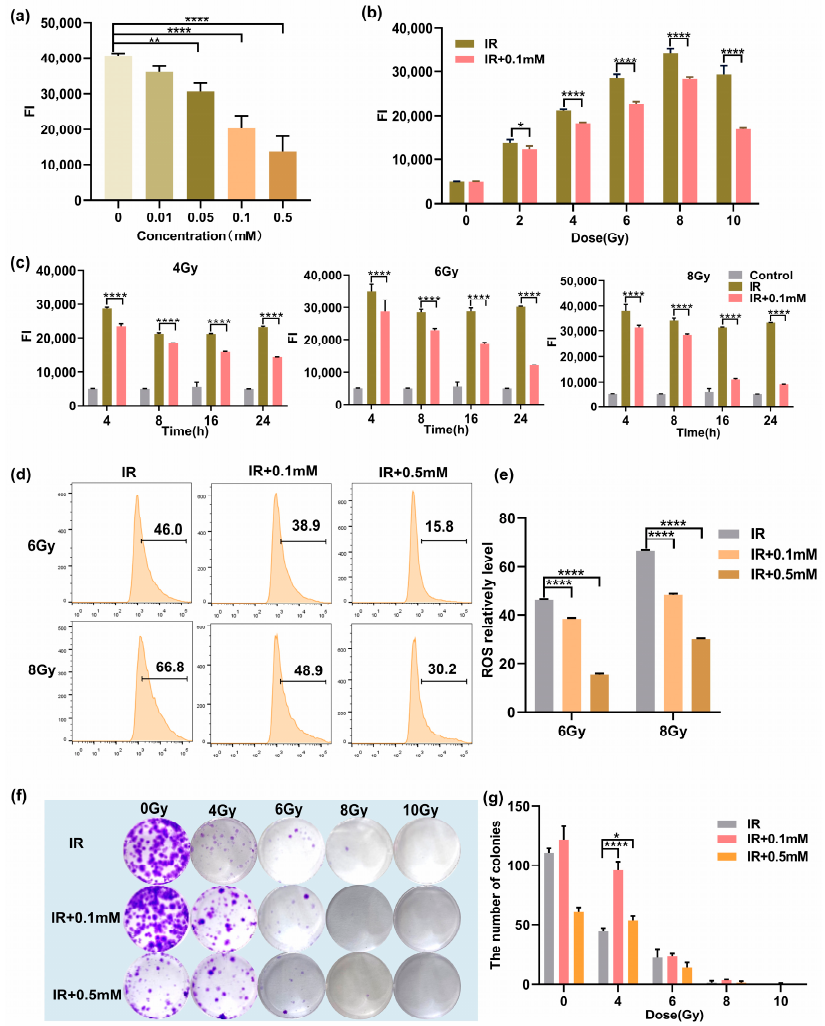
Figure 3. ( a ) The ROS levels in cells treated with various concentrations of M1 at 8 h after 4 Gy irradiation. ( b ) The ROS levels in M1 treated and untreated cells at 8 h after various doses of irradiation. ( c ) The ROS levels in M1 treated and untreated cells at various times after 4, 6, and 8 Gy irradiation. ( d ) Flow cytometry ROS analysis of HIEC-6 cells treated with groups of IR, IR + 0.1 mM, and IR + 0.5 mM at 24 h after 6 and 8 Gy irradiation (numbers represent ROS level). ( e ) Quantitative analysis of ROS level from ( d ). ( f ) Typical clone images of HIEC-6 cells belong to groups of IR, IR + 0.1 mM, and IR + 0.5 mM at 10 days after 0, 4, 6, 8, and 10 Gy irradiation. ( g ) Quantitative analysis of survival fractions from ( f ). Results are presented as the mean ± SD in triplicate and analyzed by one-way ANOVA. Meanwhile, ROS levels in the IR group, the IR + 0.1 mM group, and the IR + 0.5 mM group were quantitatively analyzed by flow cytometry. As shown in Figure 3d, compared with the IR group, the ROS levels in the IR + 0.1 mM group and the IR + 0.5 mM group were significantly reduced, and the increased drug concentration could promote the clear- ance of ROS. Quantitative analysis of ROS level is shown in Figure 3e, and results are presented as the mean ± SD in triplicate. The colony-forming cell assay was used to evaluate the proliferation and differentia- tion pattern of irradiated HIEC-6 cells exposed with/without M1 treatment. As shown in Figure 3f,g, HIEC-6 cells in the IR + 0.1 mM group irradiated with 0, 4, 6, 8, and 10 Gy had significantly higher survival fraction than the irradiated group. For the IR + 0.5 mM group, 0.5 mM M1 presented a cytotoxic effect compared with the control group (0 Gy), while higher colony counts were observed compared to the group exposed with 4Gy radiation.